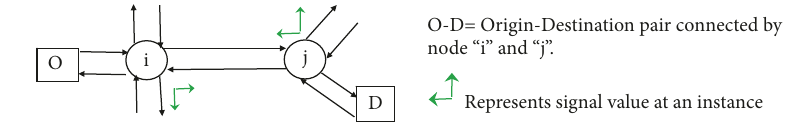
Figure 1: An intersection of the network showing an O-D pair connected by a 3-way and a 4-way junction. The green arrows denote the signal values.